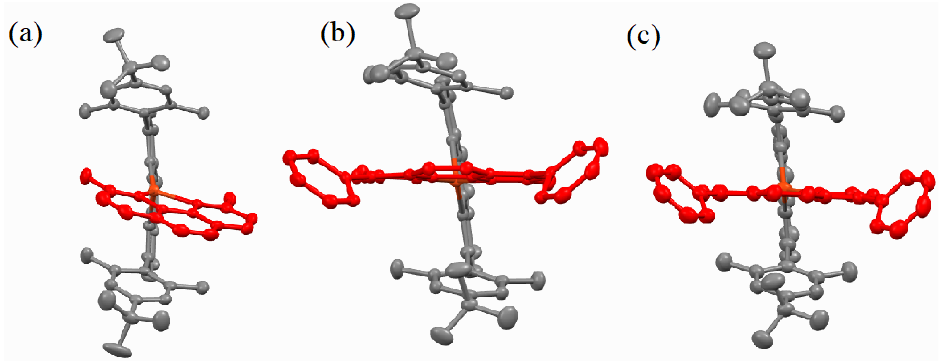
Figure 4. Orthogonal view of ( a ) C2 , ( b ) C3 and ( c ) C4 .